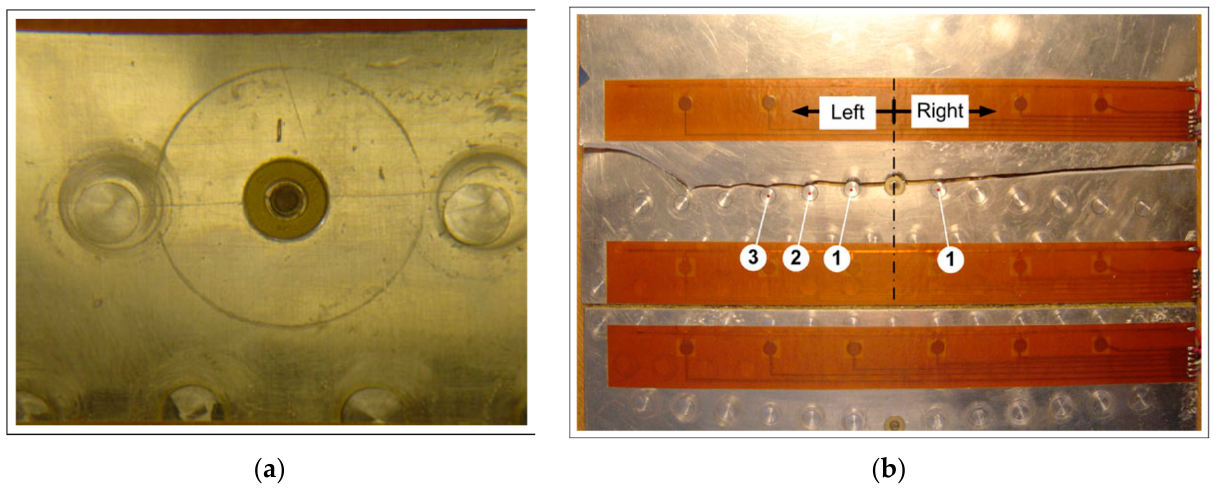
Figure 4. Monitored fatigue crack: ( a ) after 347,500 fatigue cycles; ( b ) completely fractured panel after 465,500 fatigue cycles. Numbers indicate consecutive rivets to the left and right side from the central rivet.